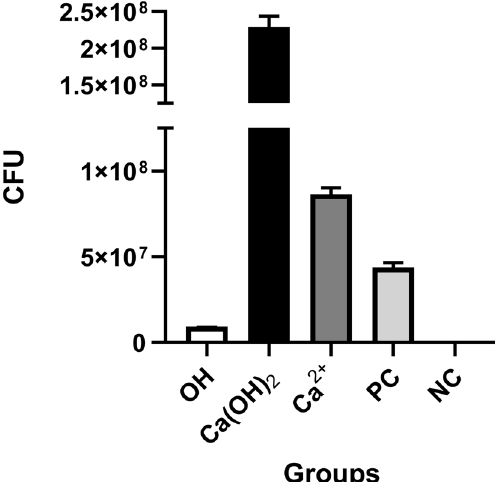
Figure 8. Quantitation of viable cells under different solutions. Abbreviations: Negative control, NC; Positive control,